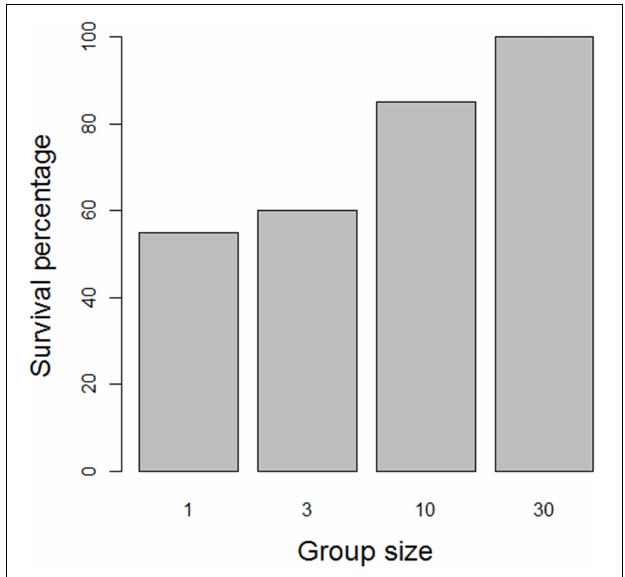
FIGURE 2 | Effect of clump size on the dislodgement of mussel clumps in a field experiment. Small clumps were dislodged significantly more often than large